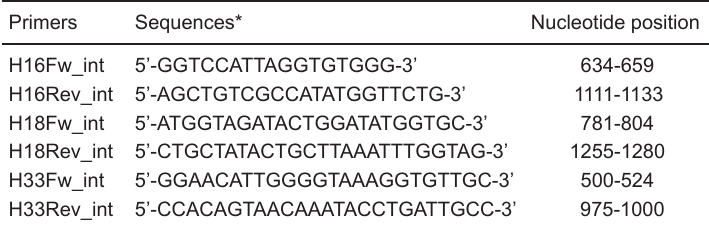
Table 3. Primers for